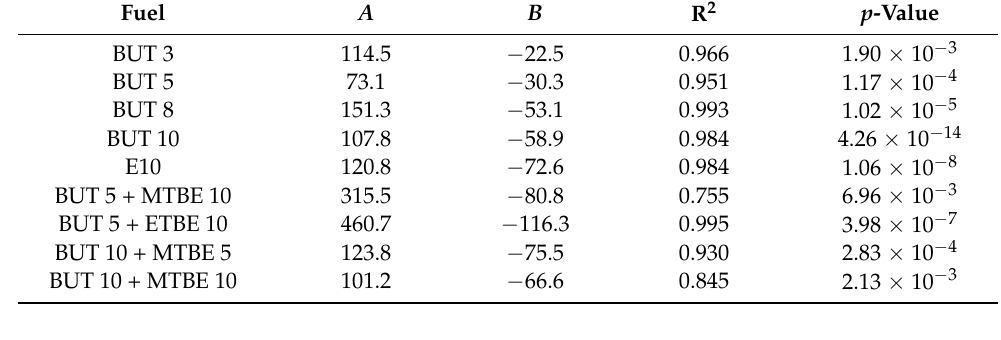
regression curve. The measurements show that the solubility of water in a mixture with